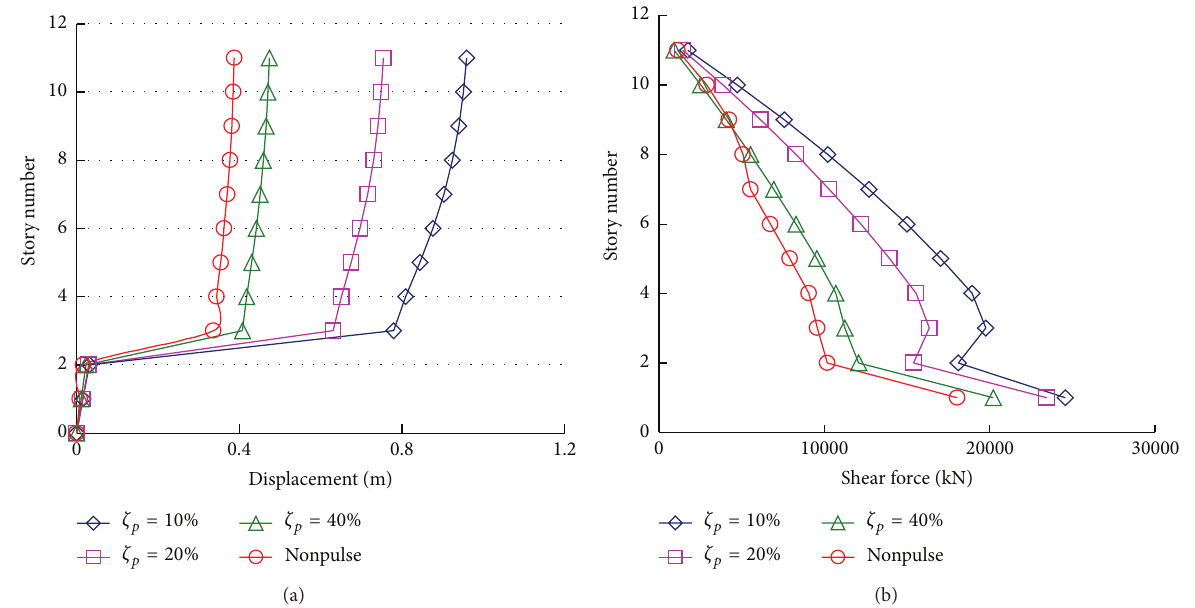
Figure 7: Responses of the midstory isolated structure under different types of near-field pulse-like ground motion. (a) Peak displacement along height of building; (b) peak shear force along height of